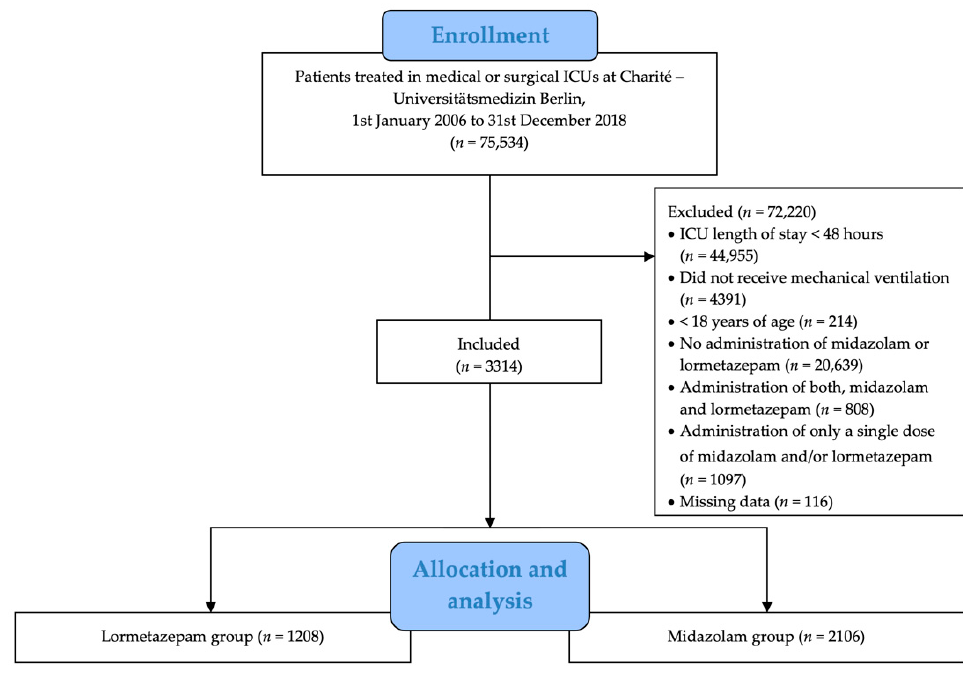
Figure 1. Inclusion and exclusion diagram.